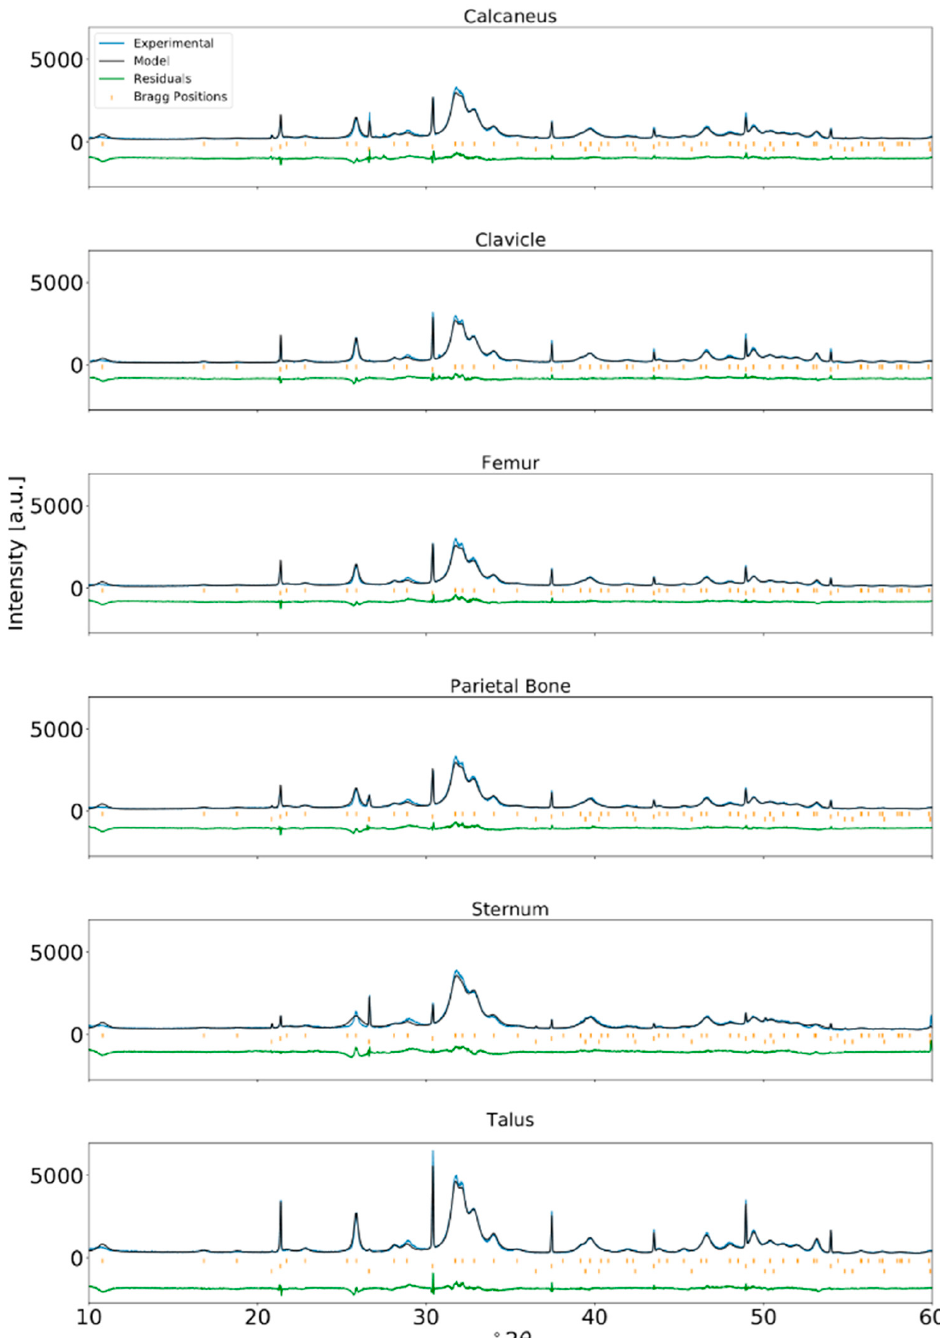
Figure A5. Rietveld refinement of XRPD data for human bone from a RBM adult and internal standard NIST LaB 6 incorporated at approximately 2 wt% ( λ = Cu-K α 1 ).